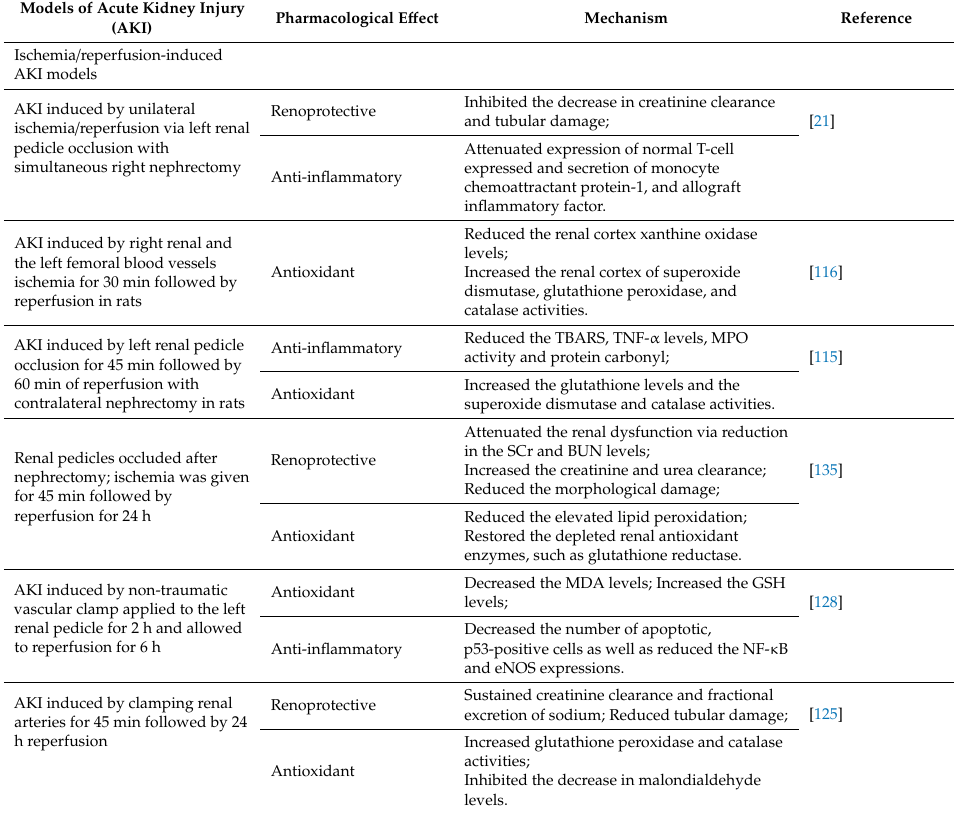
Table 1. Pharmacological e ff ect of quercetin in models of acute kidney injury (AKI). Models of Acute Kidney Injury